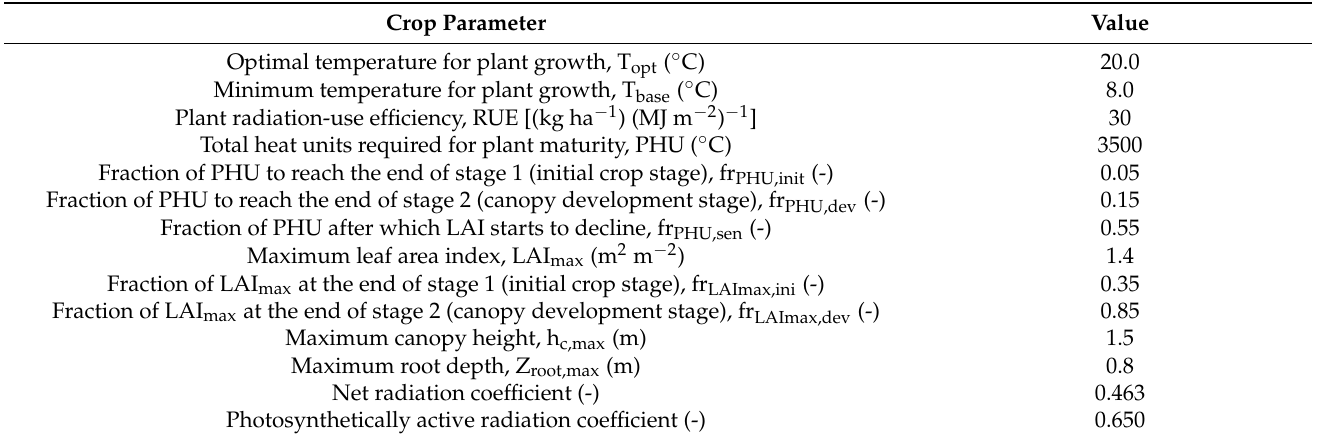
Table 1. Calibrated crop growth